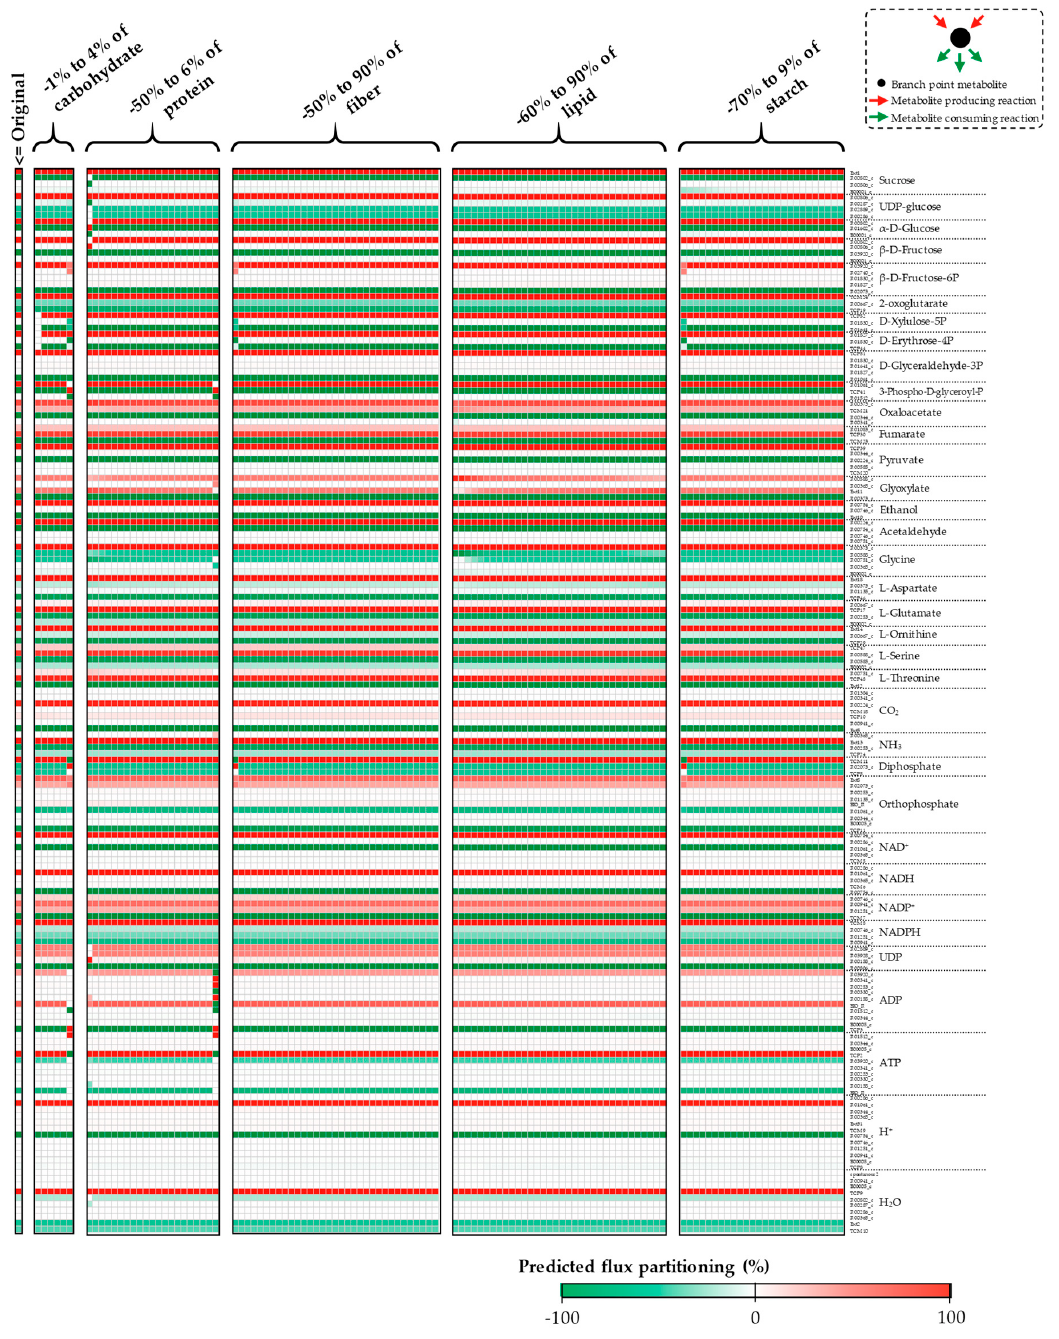
Figure A13. The sensitivity of cytosolic reaction flux partitioning to variations in biomass content. Details of the metabolic branch points along with the corresponding reactions are provided in the Supplementary Materials (File S2). A difference in grid color between the original (first column) and predicted fluxes is indicative of dissimilarity in partitioning (breakpoint). The production and consumption fluxes at each metabolic branch point were respectively denoted as positive and negative signs.